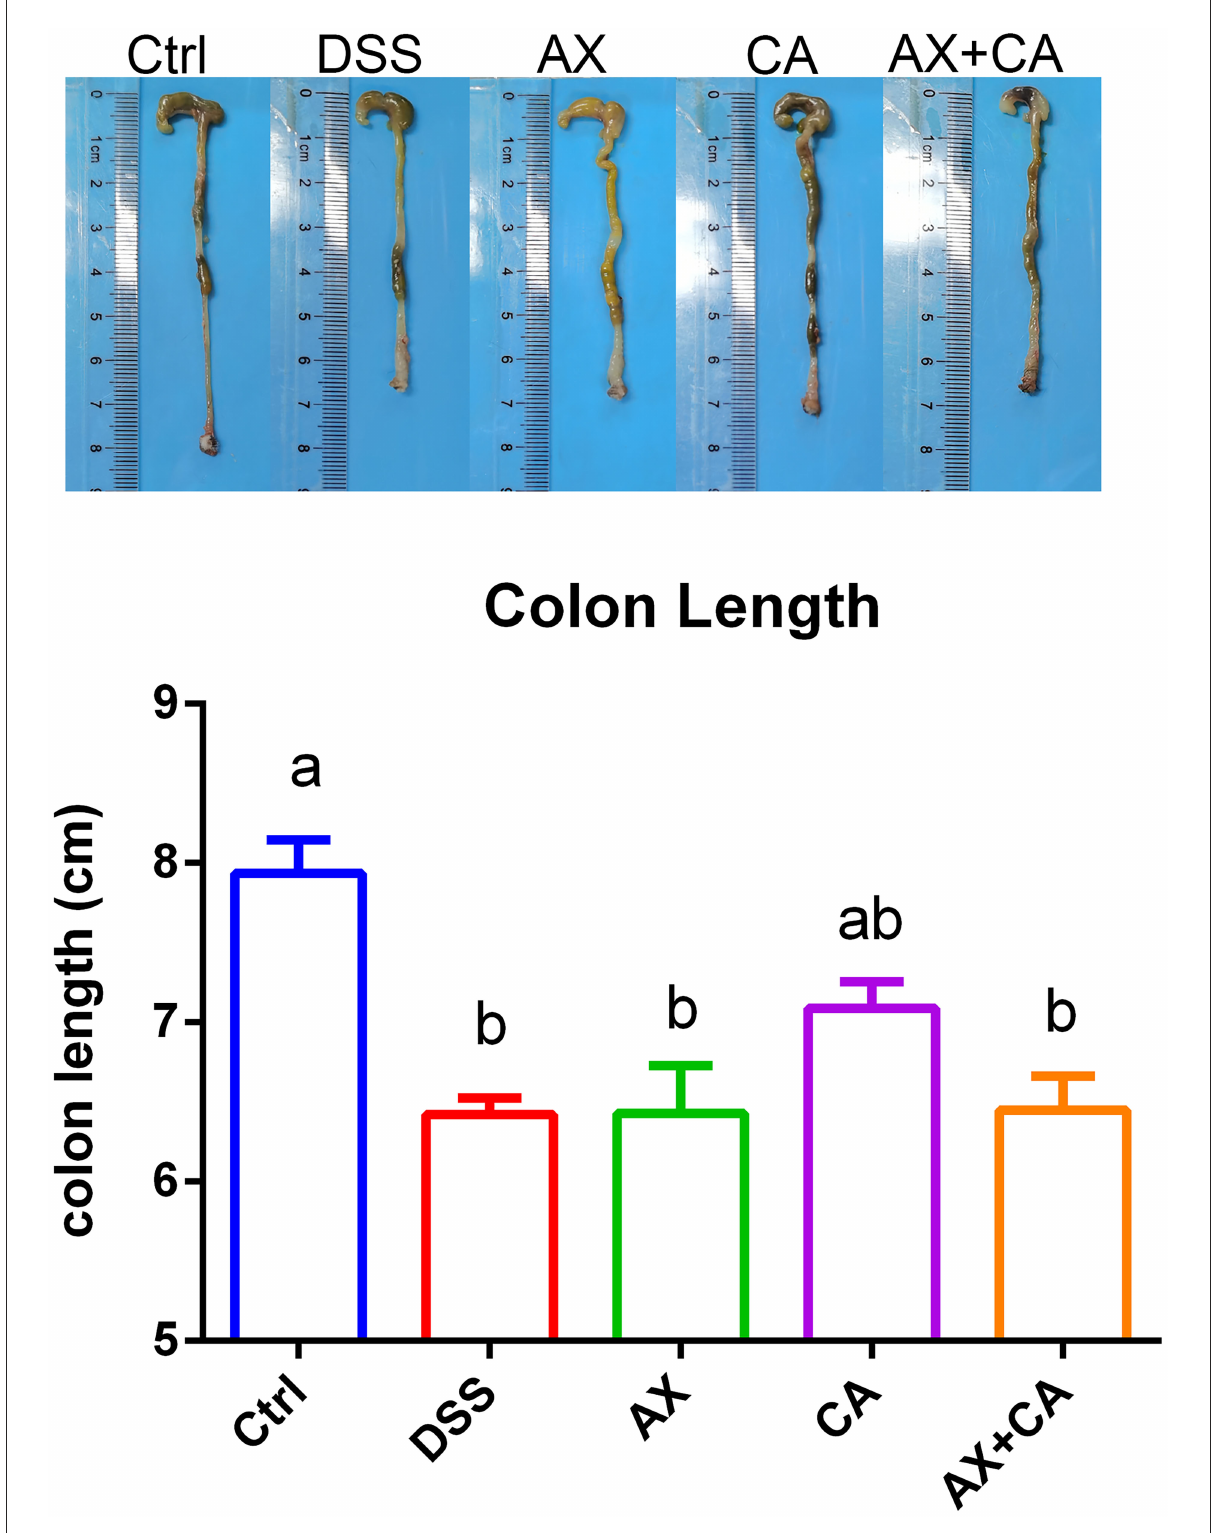
FIGURE2 Colon lengths of the mice in each